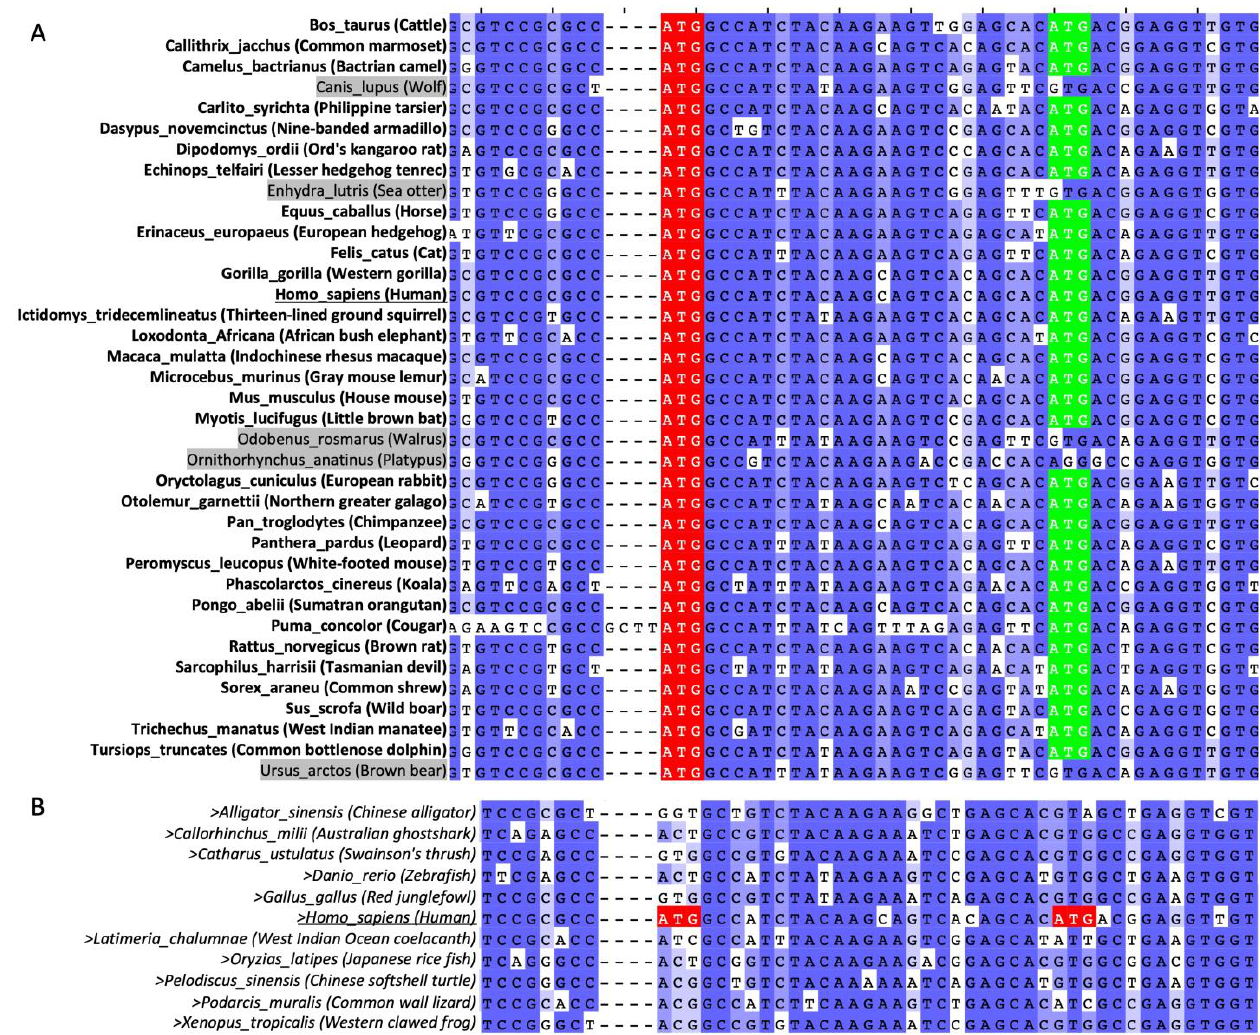
Figure 4. AUG160 orth and AUG169 orth in different chordate species. Sequence alignment of regions surrounding internal translation initiation sites (TIS) in p53 from 37 different mammalian species ( A ) or 11 different chordate species ( B ) using MAFFT server within Jalview. In ( A ) AUG orthologs for human AUG160 are shown in red and AUG orthologs for human AUG169 are shown in green.